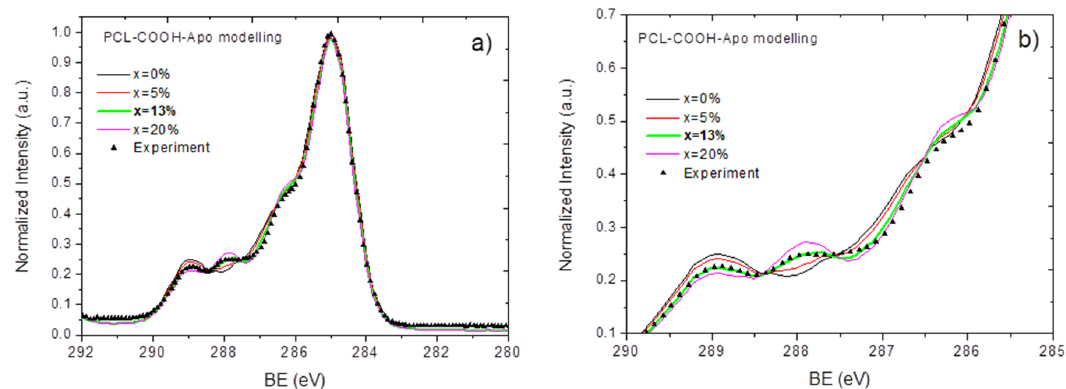
Figure 6. A comparison of the XPS C1s signals for PCL-COOH-Apo, which were measured experimentally and modeled with the different concentrations of protein (x) on the surface. An overview ( a ) and an enlarged image of the spectrum ( b ) are given to better show the effect of x on the similarity of the calculated spectrum to the experimental data.